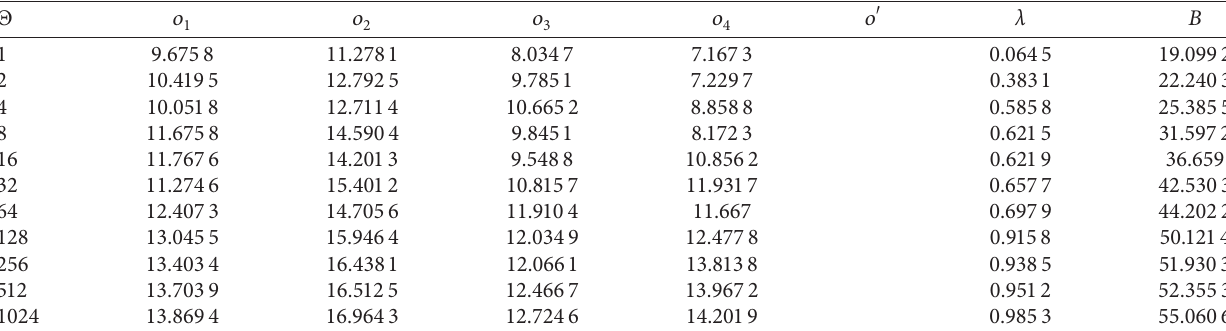
Table 2: Result of model (10).